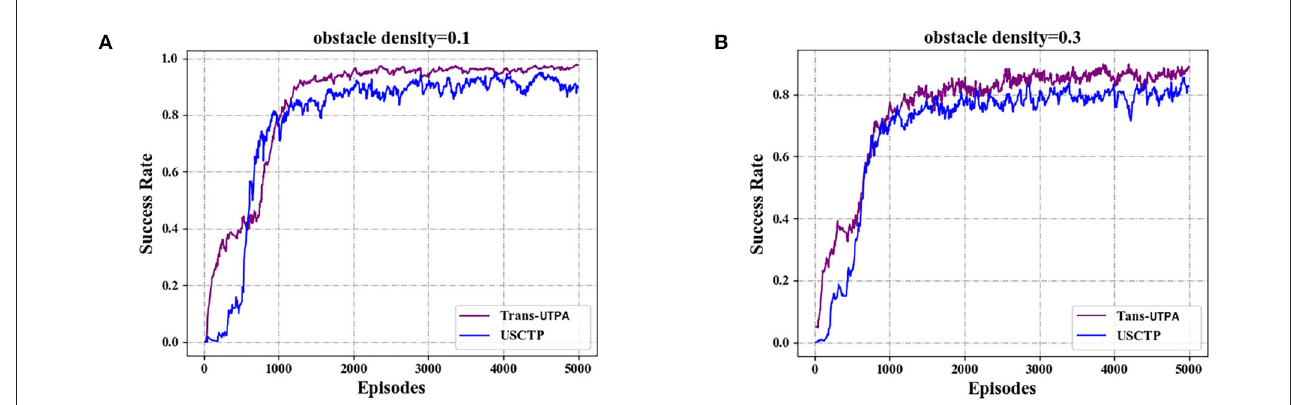
FIGURE9 Comparison of success rates of UAV swarms reaching target locations. (A) Success rate with obstacle density = 0.1. (B) Success rate with obstacle density = 0.3.